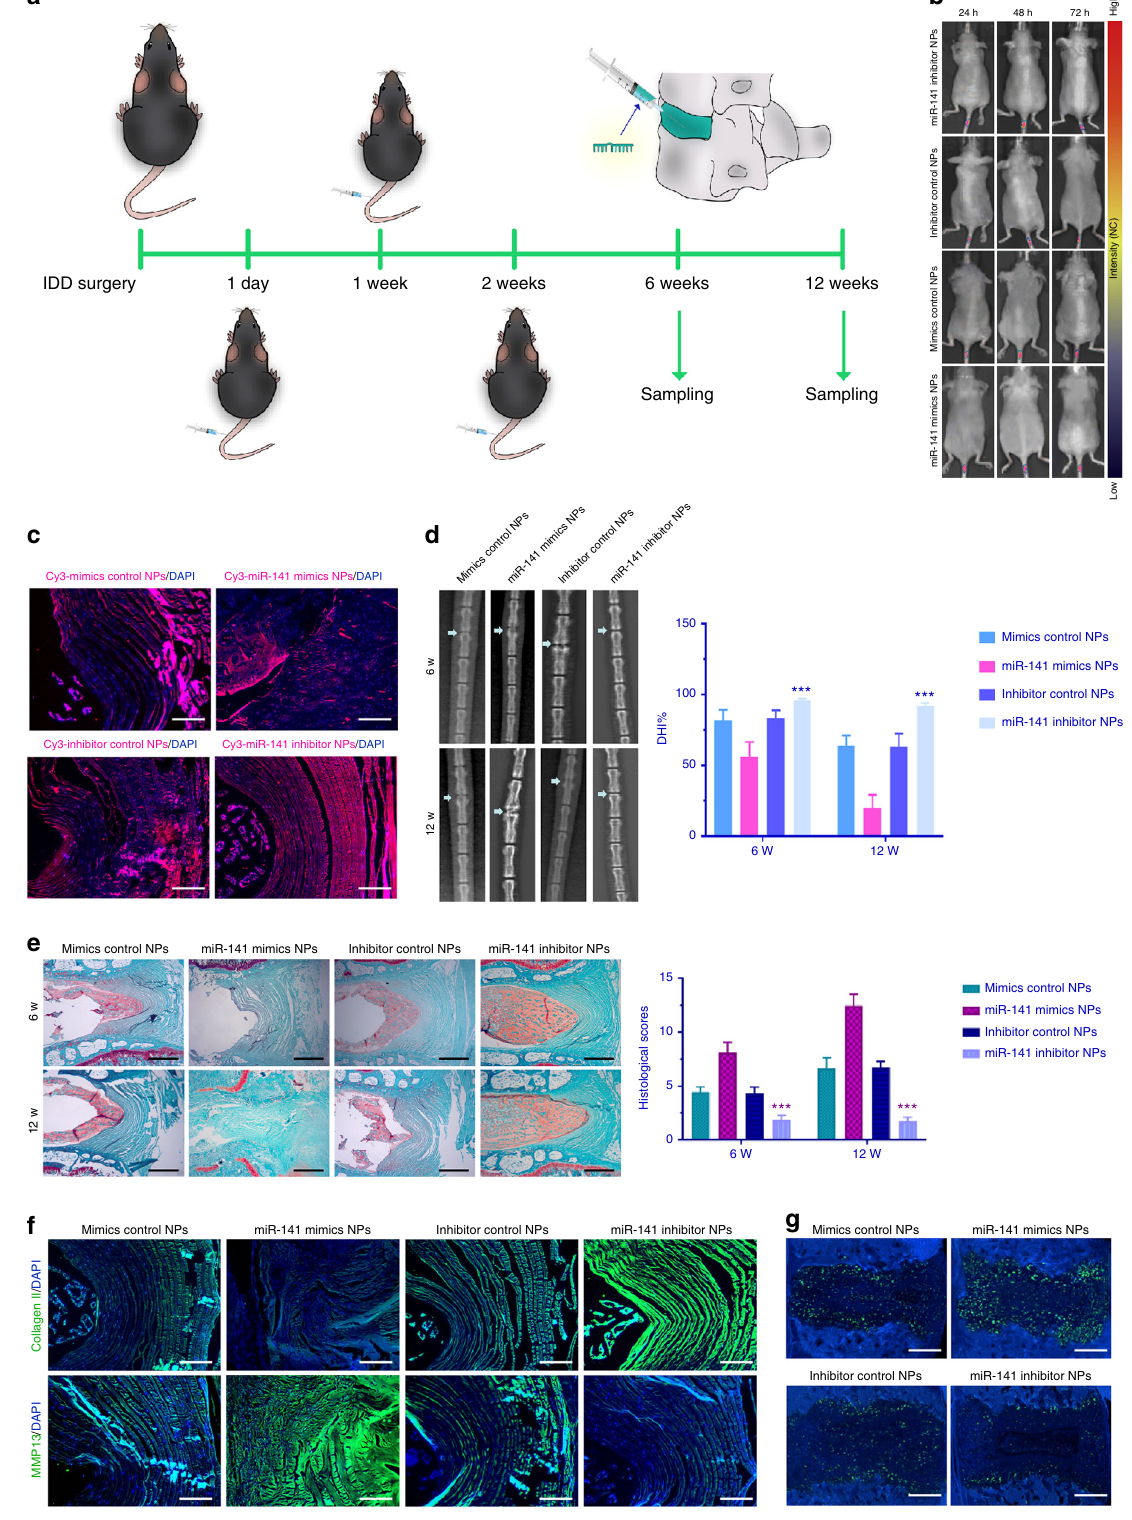
Actin level was used for normalization of the gene-speci fi c expression levels. All reactions were run on a real-time PCR system (Applied Biosystems) and analyzed using the comparative Ct ( ΔΔ Ct) method (2 − ΔΔ Ct with logarithm transformation). The speci fi c primers are listed in Supplementary Tables 2 and